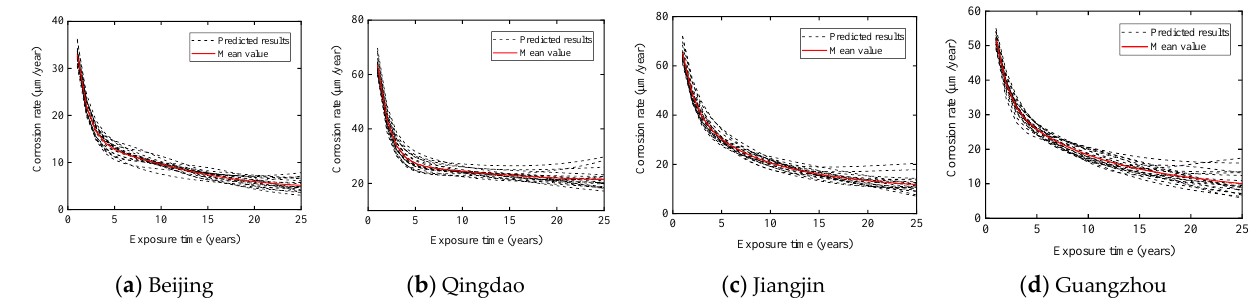
Figure 17. Predicted results of the Q345 steel corrosion rate.